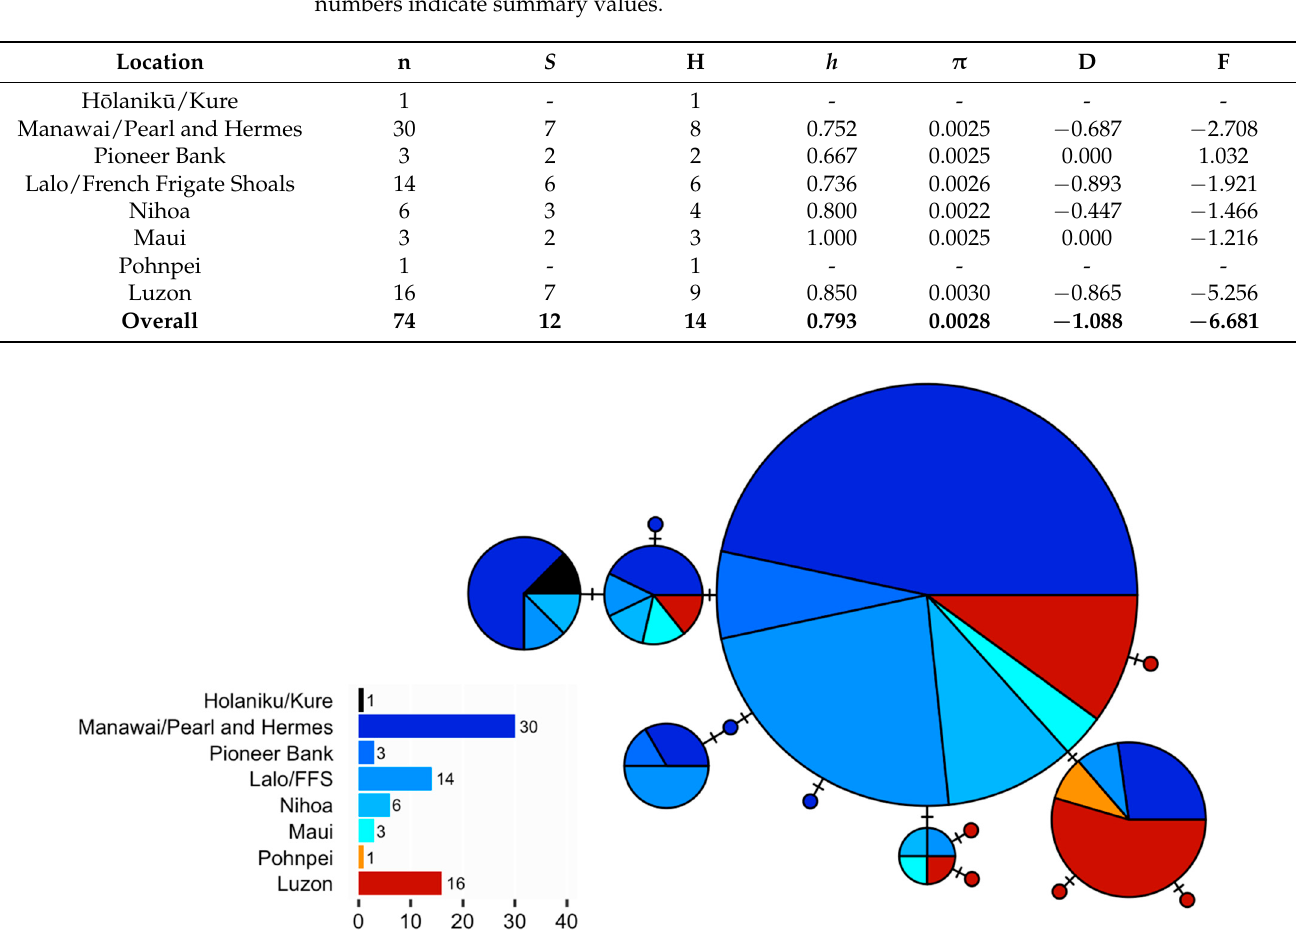
Figure 4. Neoniphon aurolineatus haplotype network. Circle sizes correspond to the frequency of each sampled haplotype. Cool colors represent samples from locations in the Hawaiian Archipelago, while warm colors represent samples from locations across the wider Indo-Pacific and correspond with those in Figure 2. Sample sizes indicated by bar graph.